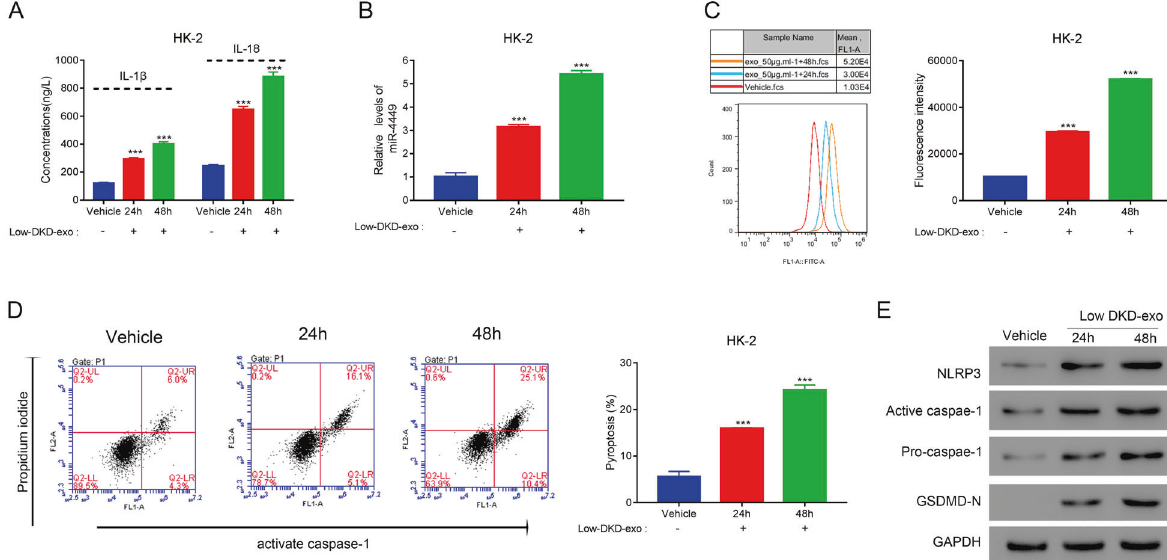
Fig. 4 DKD exosomes promote ROS accumulation and pyroptosis in kidney cells in a time-dependent manner. Exosomes from patients with low-DKD were isolated, and HK-2 cells were treated with these exosomes for 24 and 48 h. A The secretions of IL-1 β and IL-18 were quanti fi ed using ELISA. B The relative level of miR-4449 was quanti fi ed with RT-PCR. C ROS levels were quanti fi ed using the DCFDA assay kit. D Pyroptosis was measured through quanti fi cation of cells with active caspase-1. E Expression of indicated proteins was measured by western blotting. *** P < 0.001 vs.